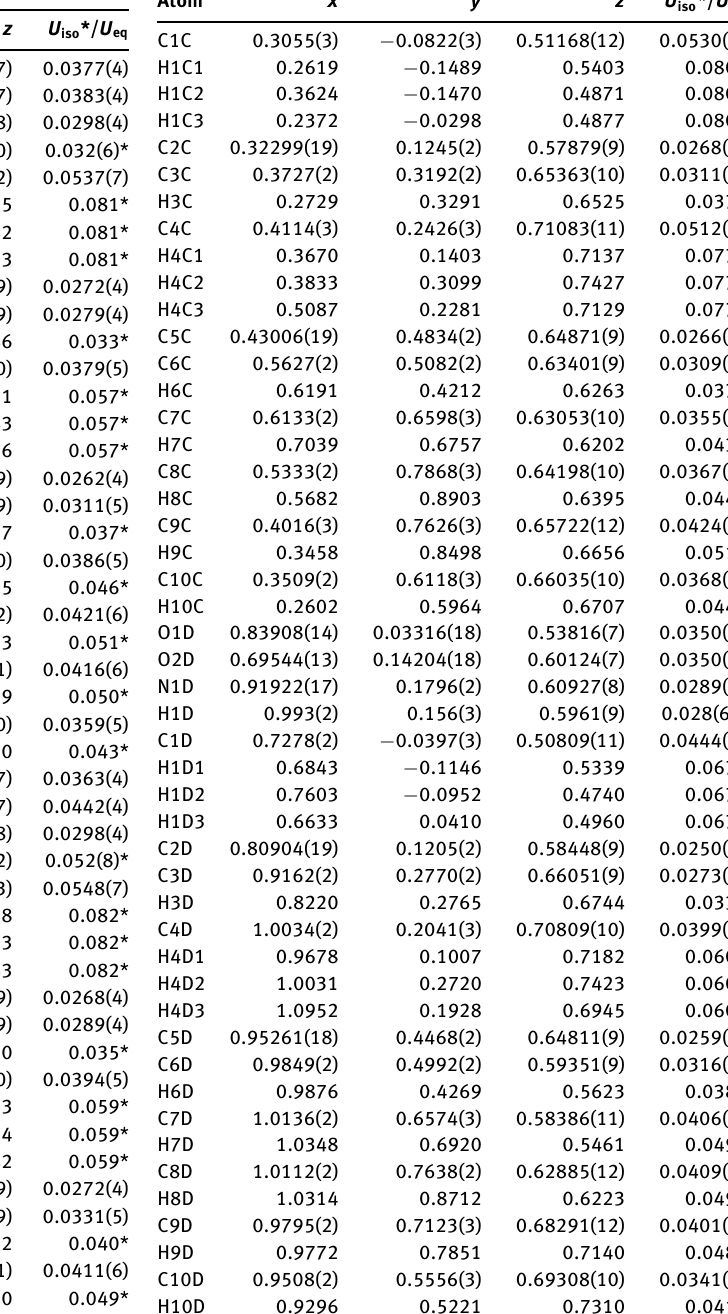
Table 2: Fractional atomic coordinates and isotropic or equivalent isotropic displacement parameters (Å 2